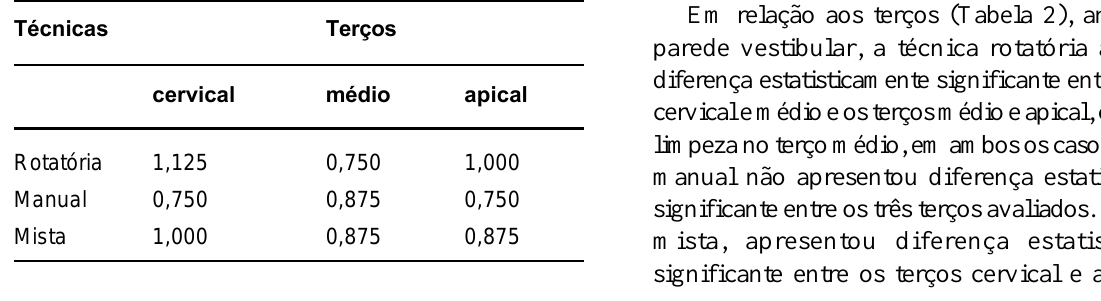
TABELA 1- Análise geral da limpeza do canal radicular proporcionada pelas três técnicas de instrumentação